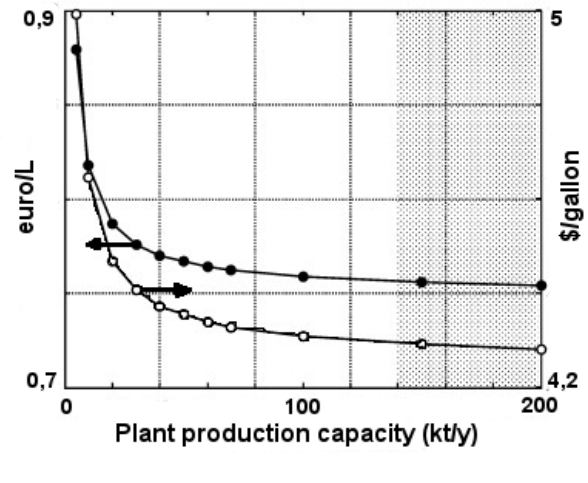
Figure 4. Illustration of correlation between RME production cost and plant capacity